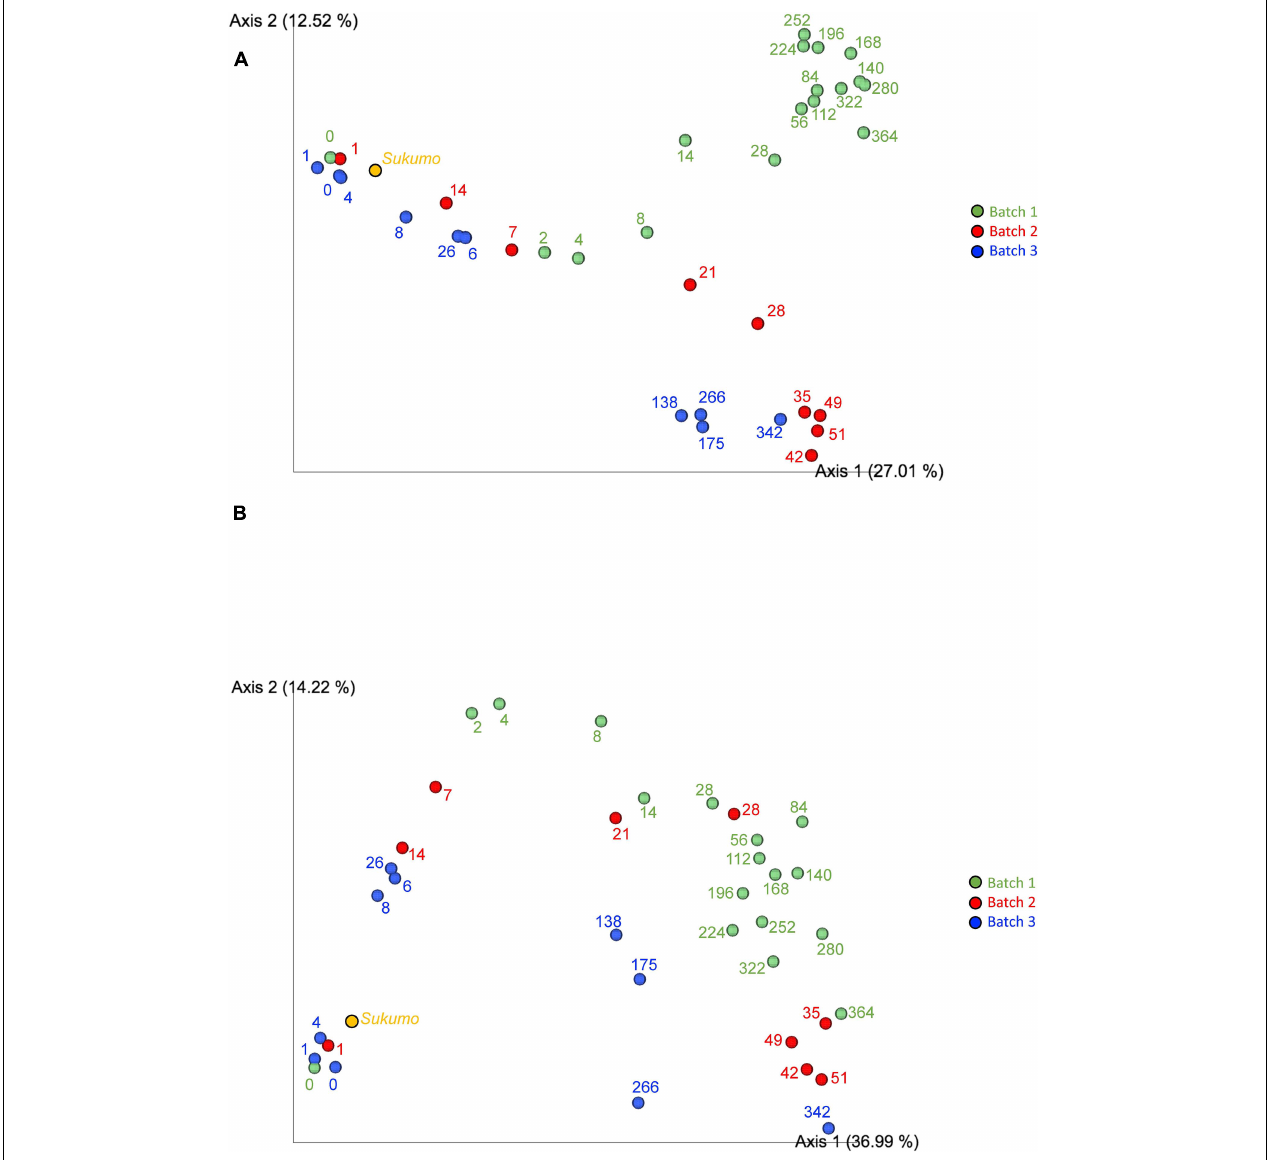
FIGURE 4 | Jaccard distance principal coordinate analysis [PCoA; Fuxman Bass et al., 2013; (A) ] and unweighted UniFrac distance PCoA analysis [Lozupone and Knight, 2005; (B) ]. Batch 1, green circles; Batch 2, red circles; and Batch 3, blue circles. Numbers indicate the fermented days. The 16S rRNA sequencing depth is 6,000 for each